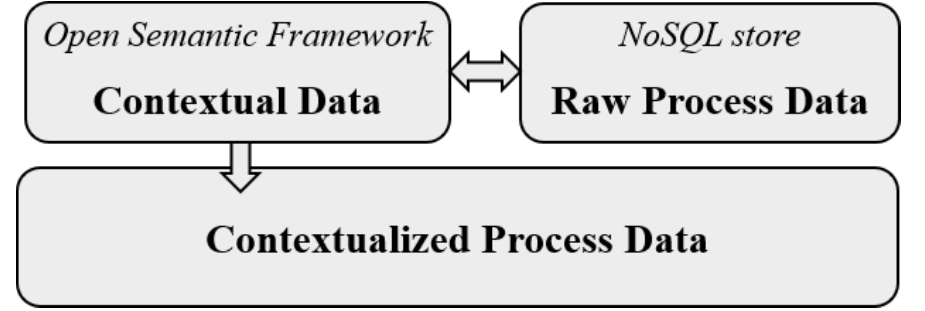
Figure 7. Contextualization of assembly line data. The figure explains a holistic view of contextualiz- ing the data from its raw form using a Semantic